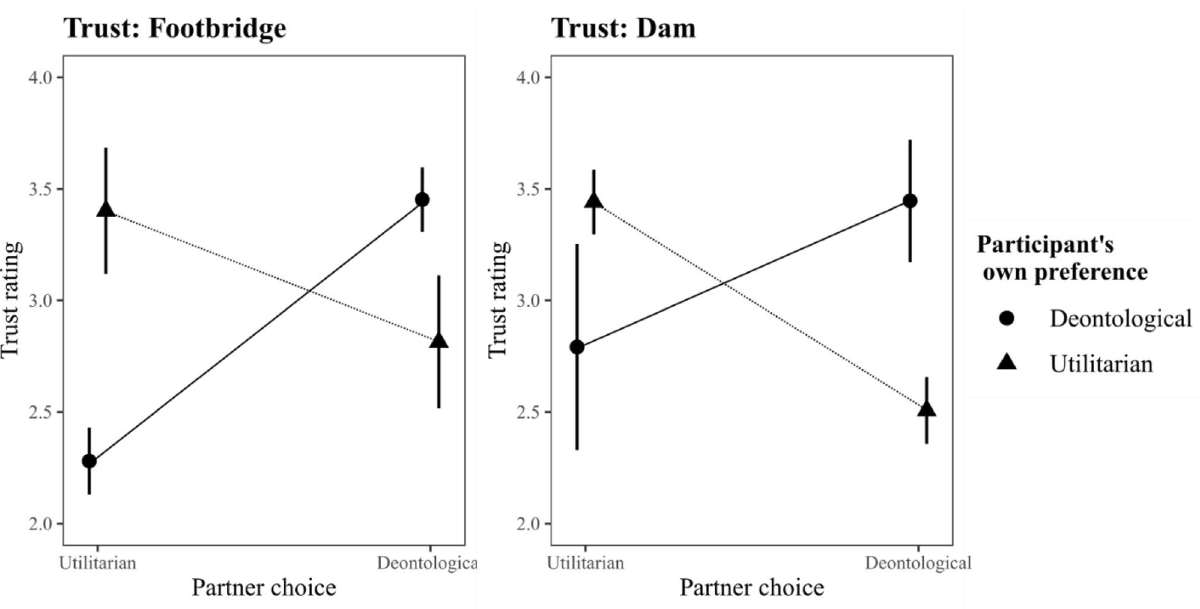
Figure 4. Inferred trust in the pilot study as a function of partner judgment and participants own moral preference for each of the two dilemmas included in that